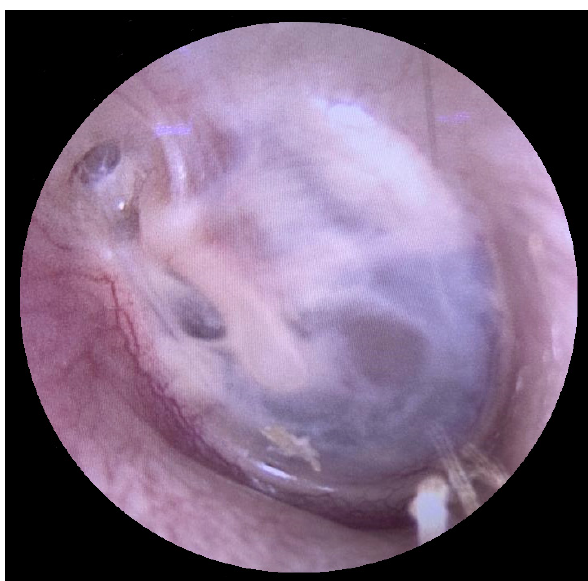
Fig. 2. Diffuse hyaline plaques on the tympanic